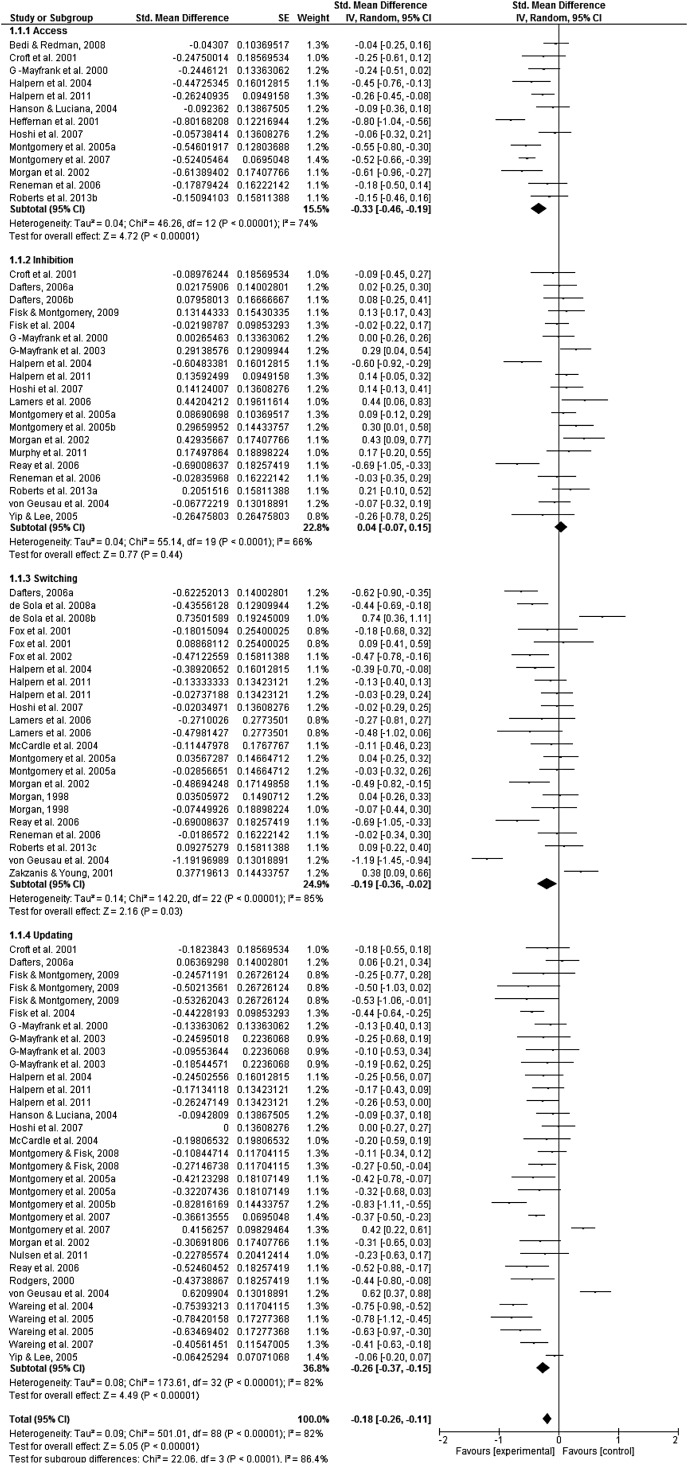
Forest plot of studies assessing executive function in ecstasy users and
drug-using controls. I2 is an indicator of
heterogeneity between comparisons. Inverse variance (IV) meta-analysis using
standardized (Std.) mean differences. SE, Standard error; CI, confidence interval;
df, degrees of freedom.